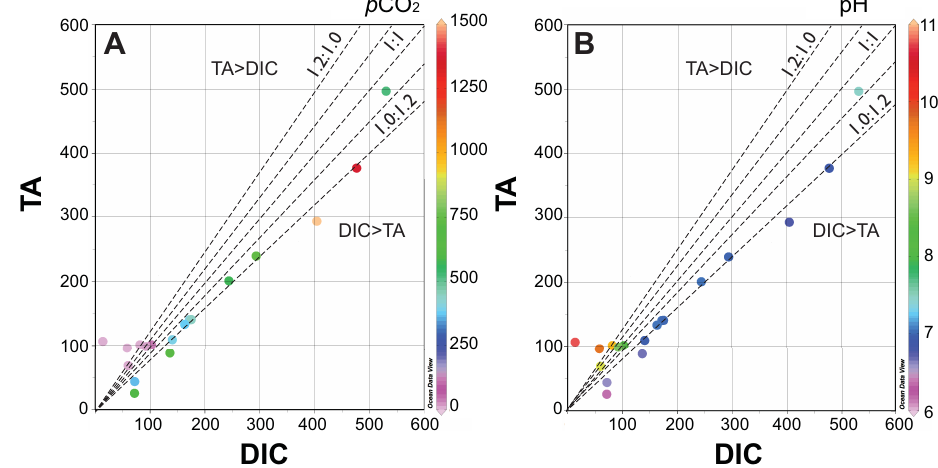
Figure 8. Scatter plots of TA and DIC against p CO 2 – µatm, panel (a) and pH, panel (b) – for above-ice melt pond water sampled during the 2010 and 2011 ICESCAPE cruises in the western Arctic Ocean. The trend lines of TA:DIC ratios from 1 . 2 : 1 . 0 to 1 . 0 : 1 . 2 are shown. pond data falls within the very large envelope of